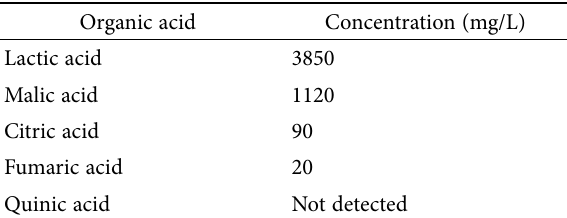
Table 2. Types and quantities of organic acids detected in molasses hydrolysate